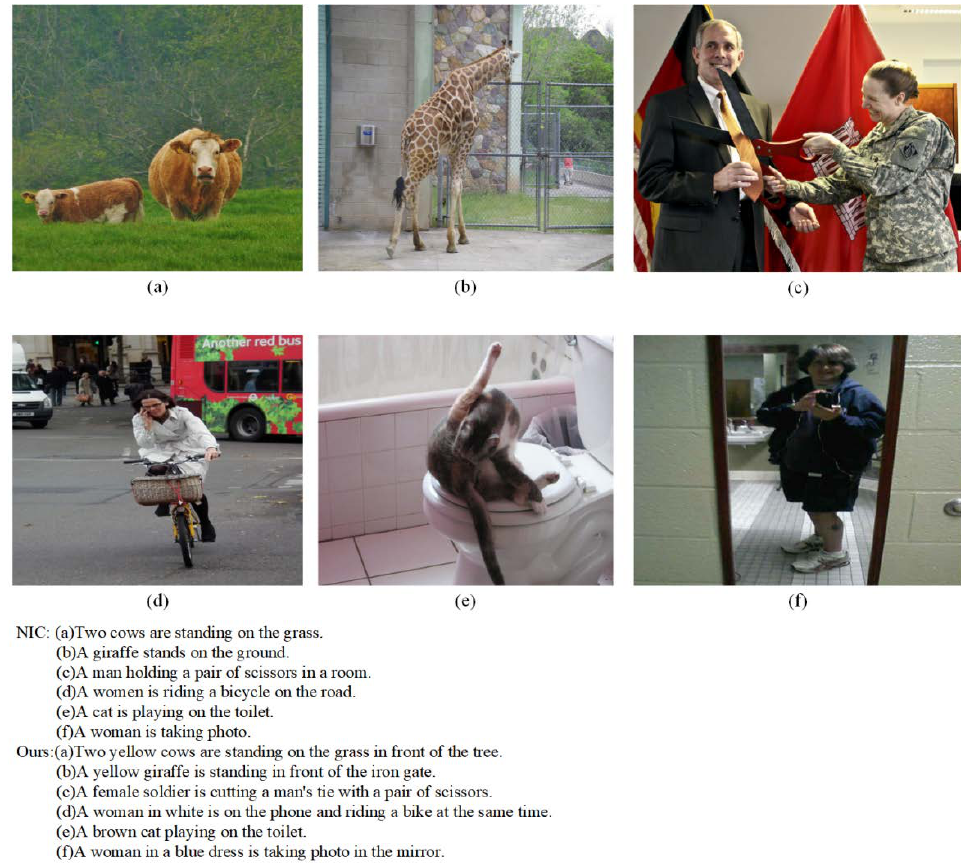
Figure 4. Display diagram of title generation results.